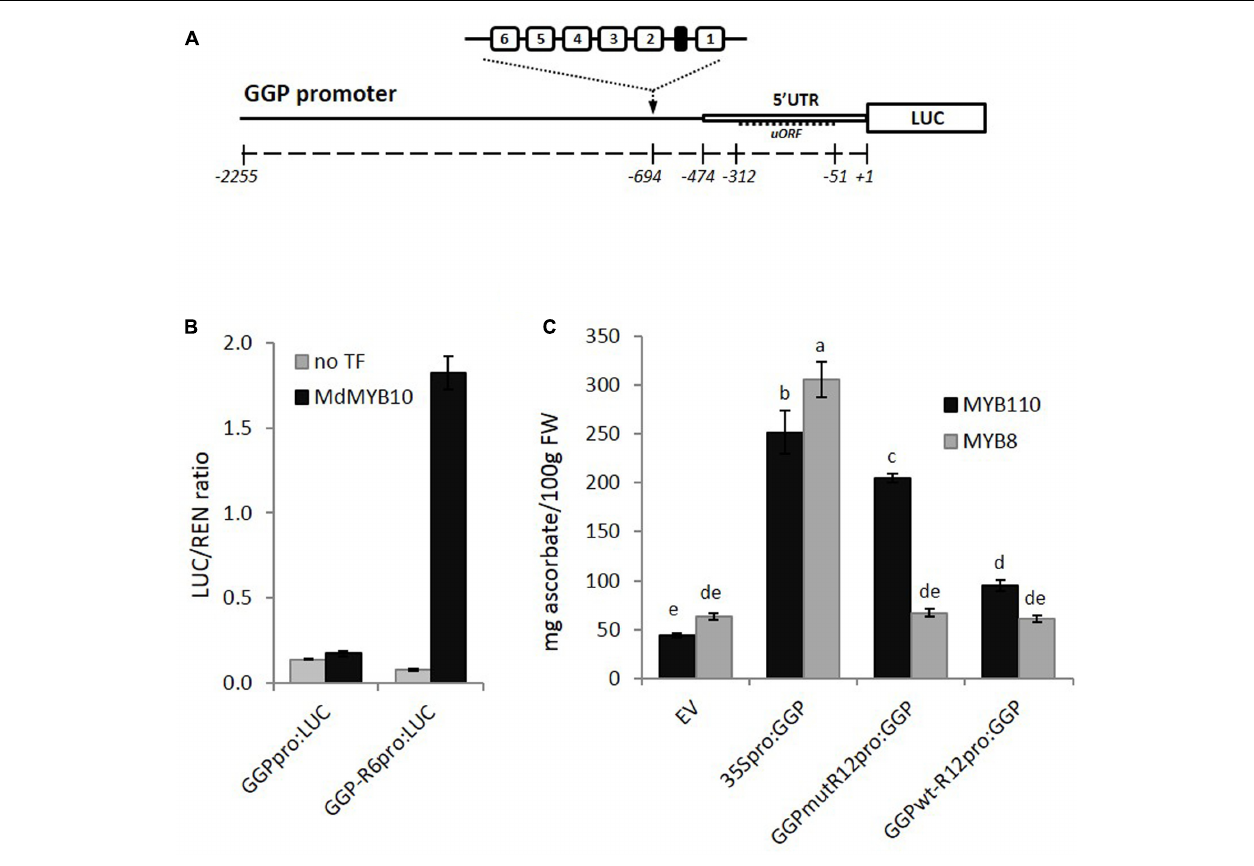
FIGURE 8 | Effect of inserting the R6 motif in the GGP promoter. (A) Schematic of the engineered GGP promoter fused to the LUC reporter gene in pGreen0800LUC representing the position of two R6 insertions upstream of the 5 (cid:48) UTR and uORF (open box and dash line respectively). (B) Dual luciferase assay of the GGP promoter harboring the R6 motif fused to the LUC reporter. Promoter constructs were co-infiltrated in N. benthamiana with MdMYB10 and MdbHLH3. Luminescence of LUC and REN was measured 3 days post-infiltration and expressed as a ratio of LUC to REN. Data represent means ( ± SE) of four replicate reactions. (C) The GGP cDNA, placed under its own promoter engineered with two copies of the R6 motif and harboring or not a single point mutation of the uORF start codon ( GGPmut-R12 pro :GGP and GGPwt-R12 pro -GGP , respectively), or placed under the control a 35S promoter ( 35S pro :GGP ), or the corresponding empty vector (EV) were co-infiltrated with AcMYB110 (or the MYB8 negative control). Ascorbate content was measured at 5 dpi. Data represent means ( ± SE) of six biological replicates. One-way ANOVA test was applied and resulting grouping information was obtained using the Tukey method, columns sharing the same letters are not significantly different at P <